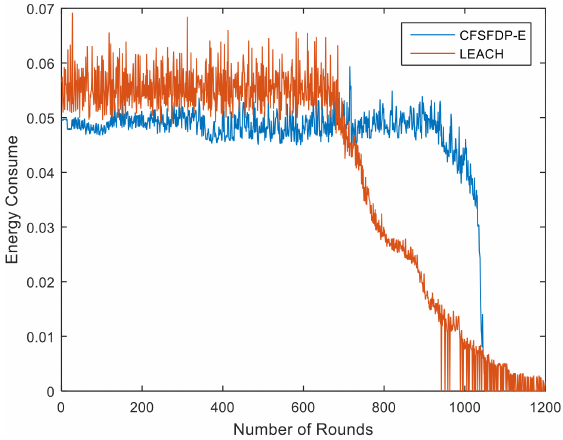
Figure 4. Energy consumption of LEACH and